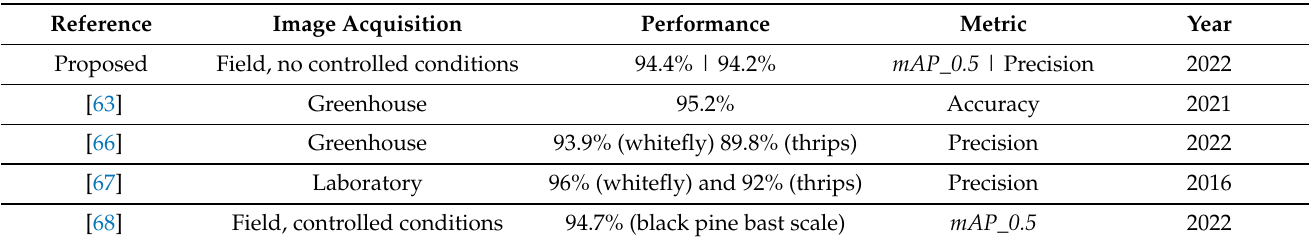
Table 7. Comparison with other insect detection